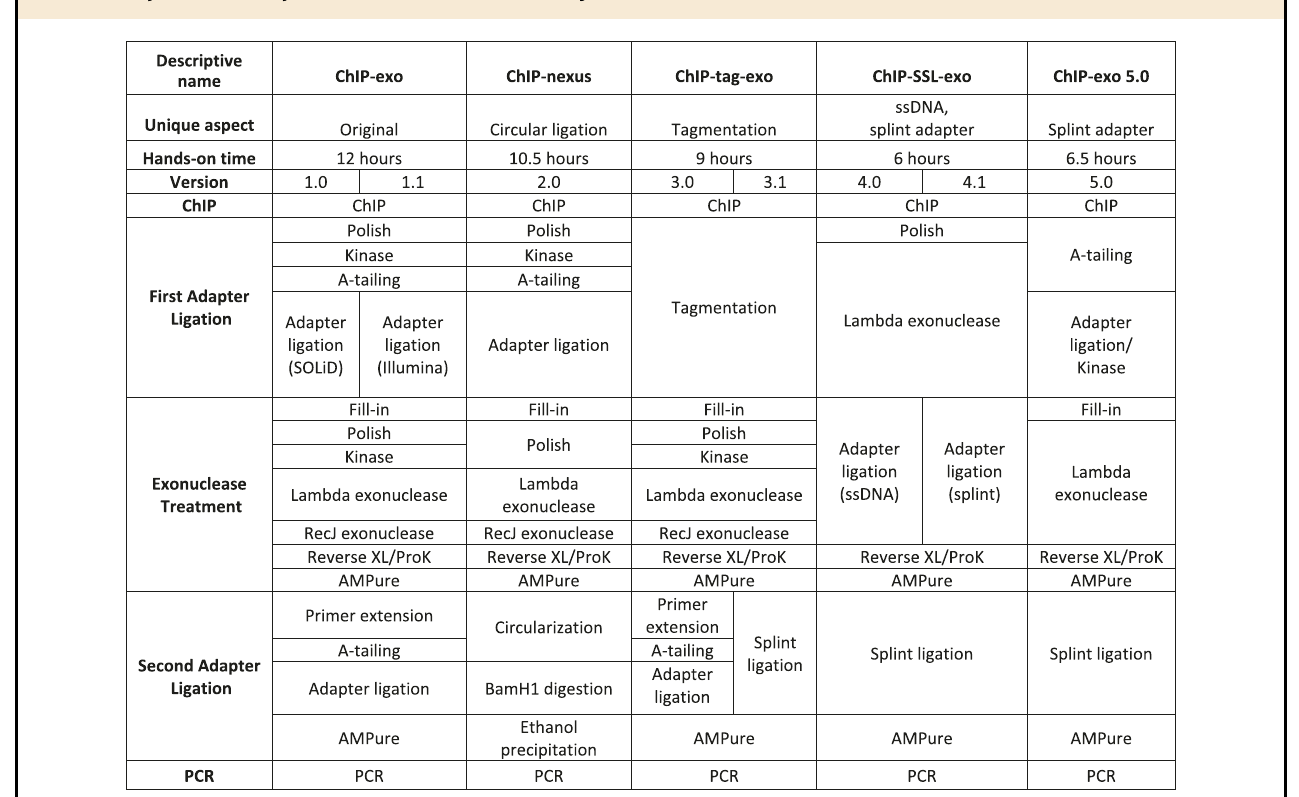
Table 1 Comparison of steps used in each ChIP-exo assay